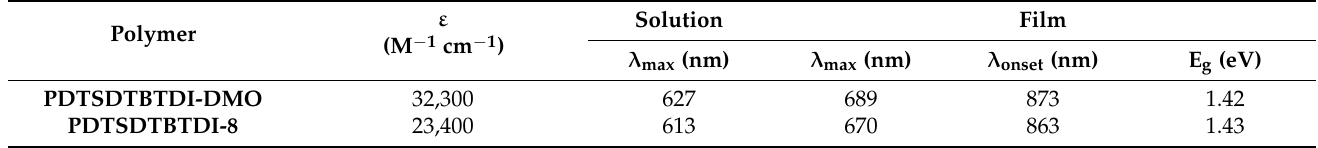
Figure 1. Normalized UV-vis absorption spectra of PDTSDTBTDI-DMO and PDTSDTBTDI-8 in ( a ) chloroform solutions; and ( b ) on thin films. Table 2. The UV-vis data and optical band gaps of the